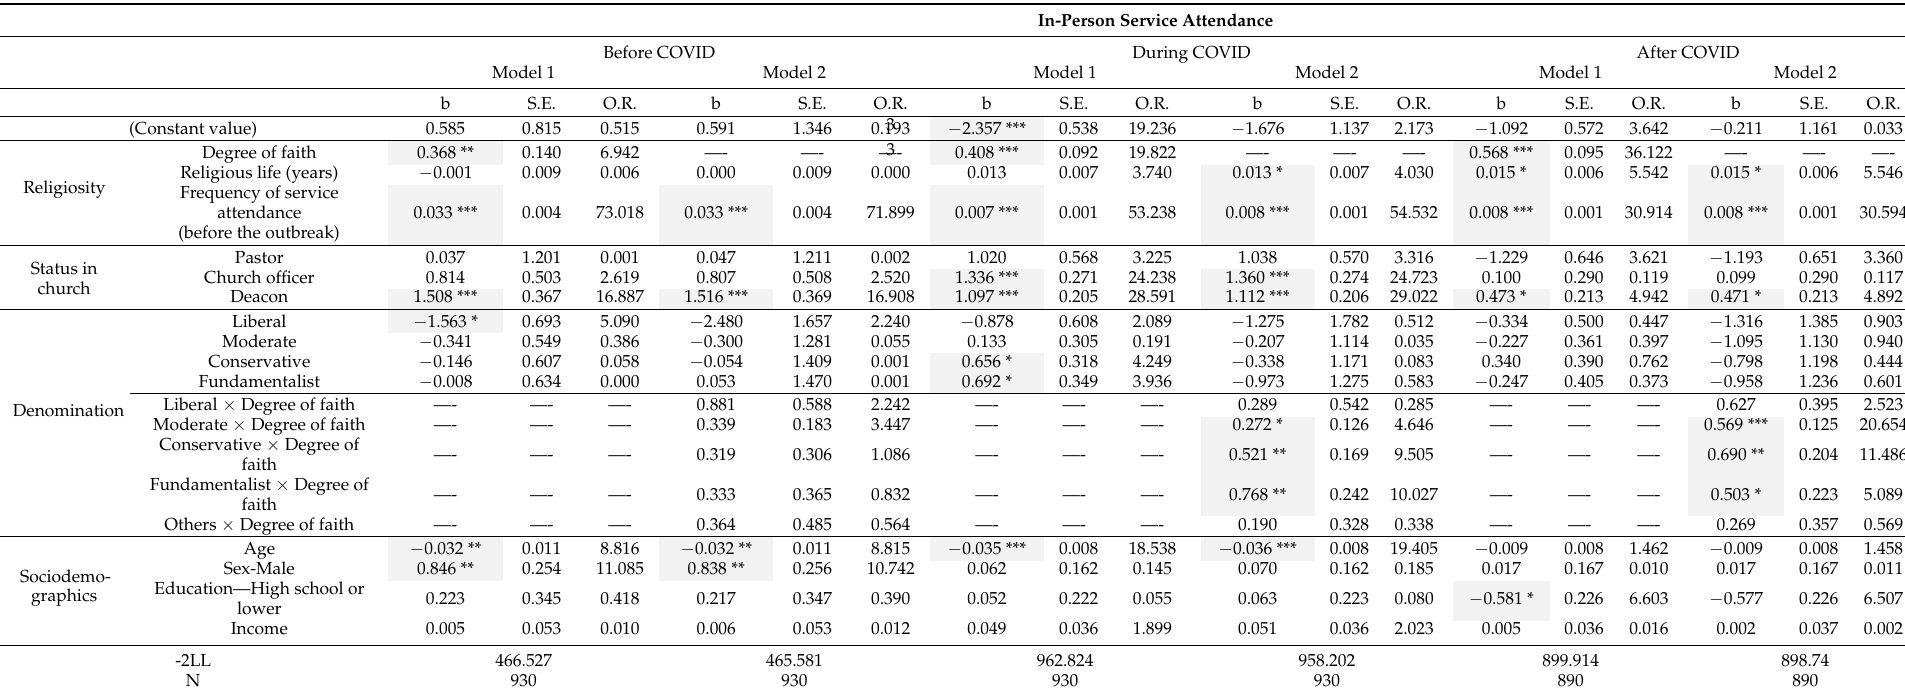
Table 14. Logistic regression models predicting Protestants’ attitudes toward in-person service